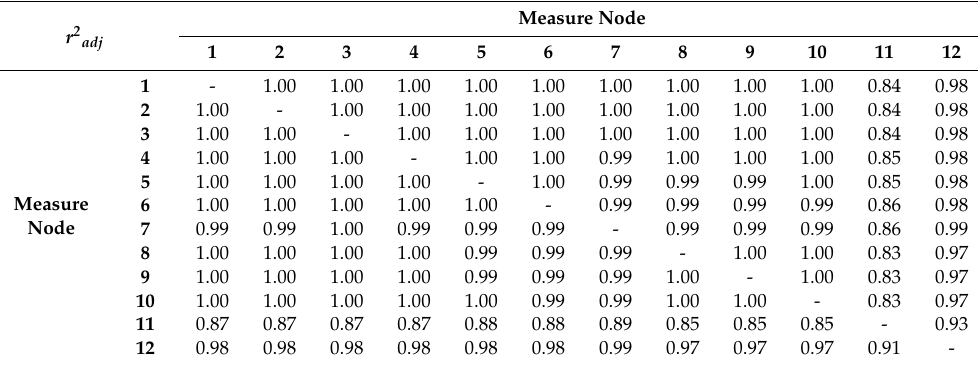
Table 6. r 2 adj of case 6 in a TVSTR model.